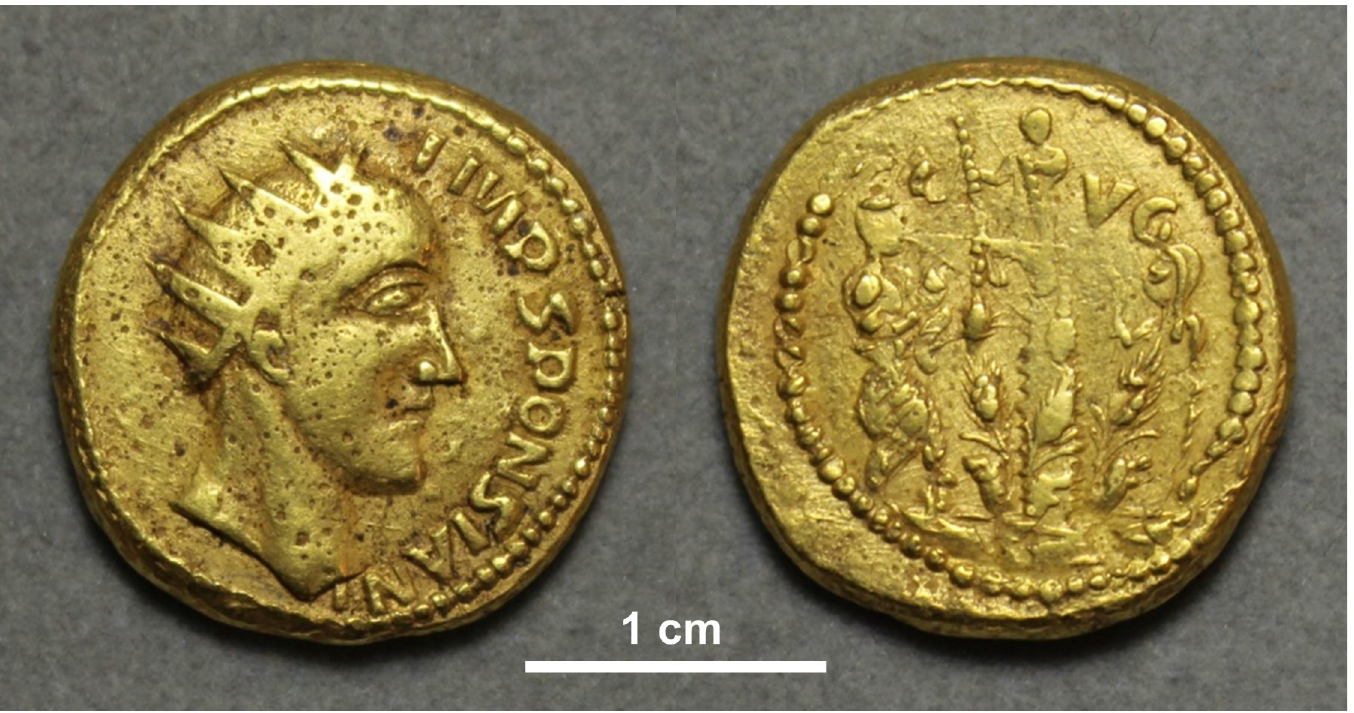
Fig 1. Coin of the ‘emperor’ Sponsian, currently in The Hunterian, University of Glasgow, UK, catalogue number GLAHM:40333. Reproduced from Ref. [1].